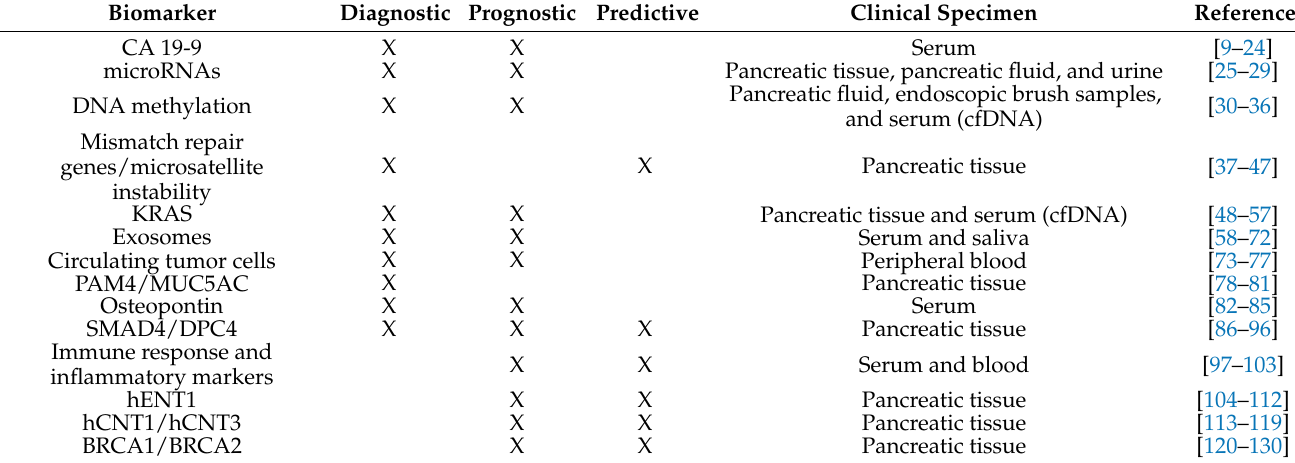
Figure 1. Illustration of the spectrum and variability of biomarkers involved in the diagnosis, prognosis, and prediction of pancreatic cancer. Table 1. Summary of the main roles of commonly used biomarkers. CA 19-9: carbohydrate antigen 19-9; MUC5AC: mucin 5AC; SMAD4: mothers against decapentaplegic homolog 4; DPC4: deleted in pancreatic cancer; hENT1: human equilibra- tive nucleoside transporter 1; hCNT: human concentrative nucleoside transporter; BRCA: breast cancer susceptibility pro- tein.